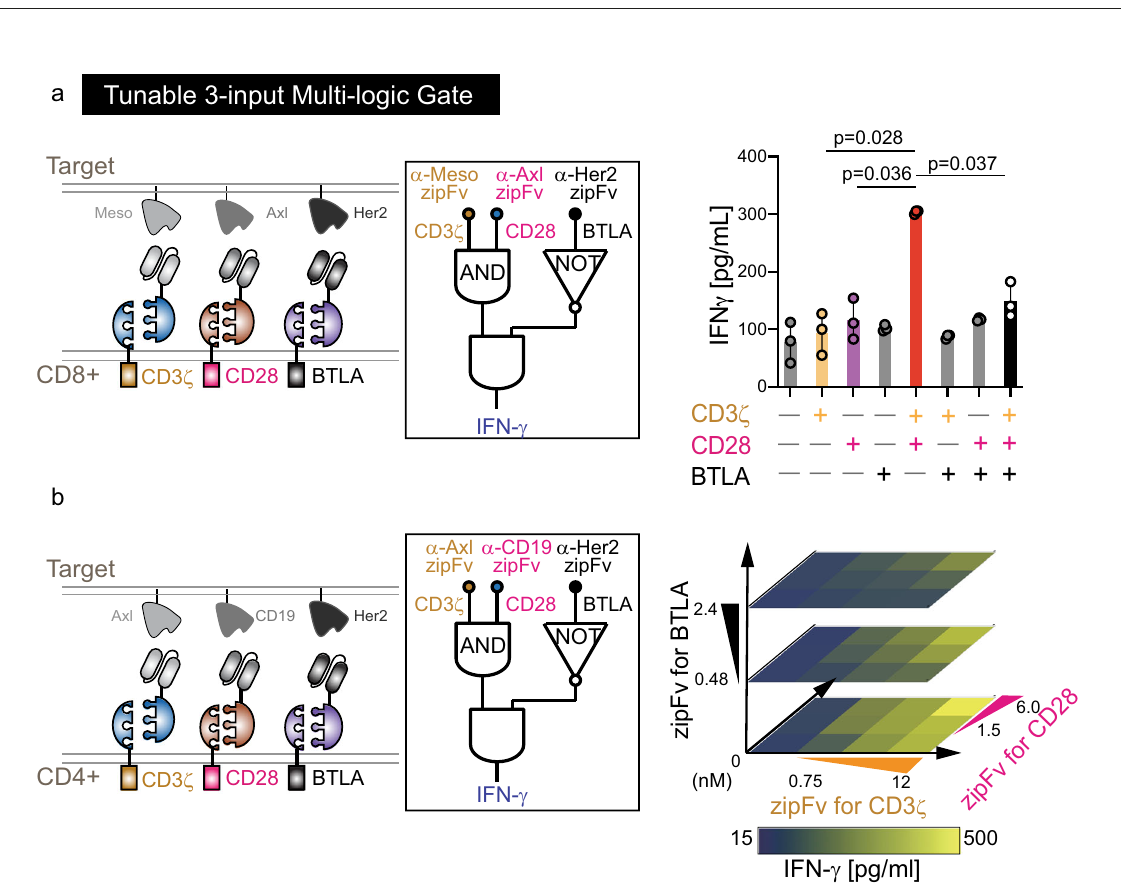
Fig. 5 Tunable 3-input multilogic in the single cell. a Design of orthogonal SUPRA CARs that control CD3 ζ , CD28, and BTLA signaling domains inducibly and independently. Primary CD8 + T cells were engineered to express FOS zipCAR, SYN6 zipCAR and SYN1 zipCAR that contain CD3 ζ domain, CD28, and BTLA signaling domain, respectively. In addition, α -Meso-SYN9 zipFv, α -Axl-SYN5 zipFv, and α -Her2-SYN2 zipFv lead to activation of CD3 ζ , CD28, and BTLA, respectively. (Right) IFN- γ secretion was measured after co-culturing with Her2, Axl, and Meso expressing Nalm6 target cells with different zipFv combinations ( n = 3, data are represented as the mean + SD, the statistical signi fi cance was determined by Student ’ s t -test). b Primary CD4 + T cells expressing FOS-CD3 ζ , SYN6-CD28, and SYN1-BTLA were co-cultured with Her2, Axl, and CD19 expressing Nalm6 target cells. The 3D heatmap